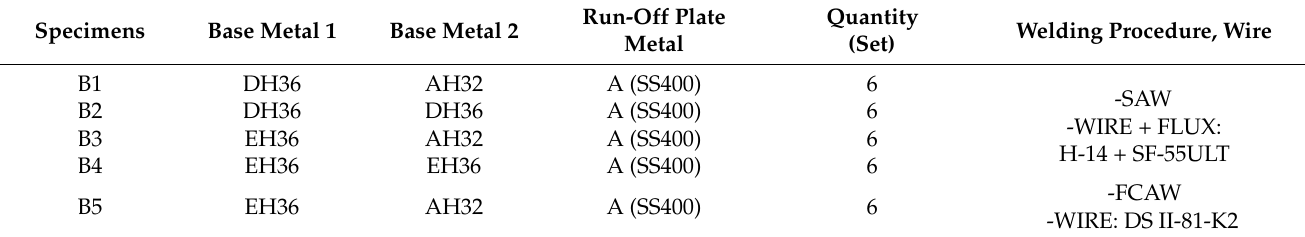
Figure 2. Welding specimens: ( a ) SAW (B1) and ( b ) FCAW (B5). Table 3. Material and quantity.